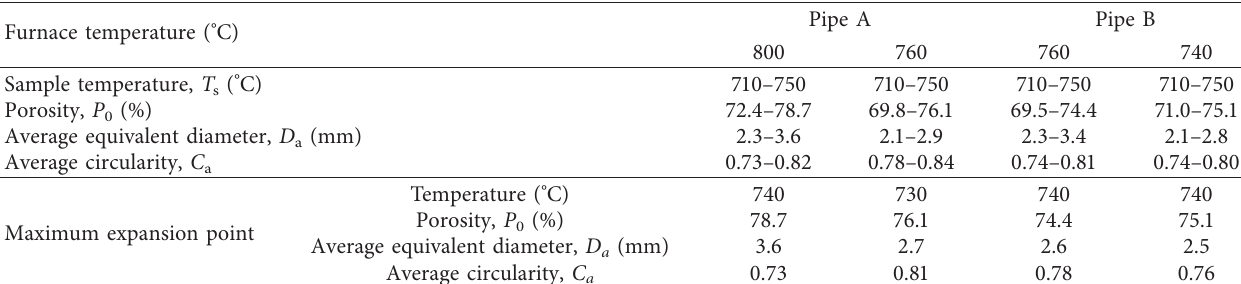
Table 3: The structure parameters of pores in samples at different furnace